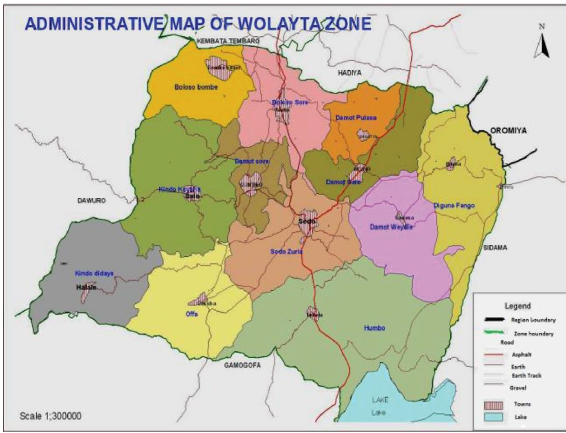
Figure 1: Map of study setting (Source: https://touristinfo.ning.